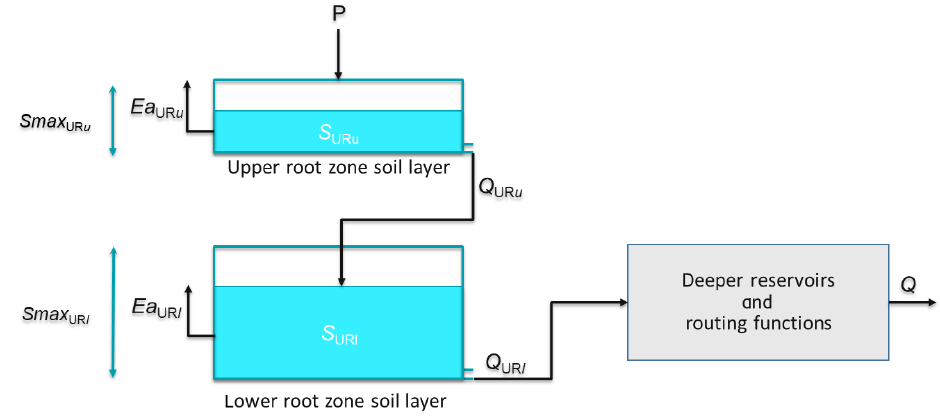
Figure 2. SUPERFLEX (SFX) model